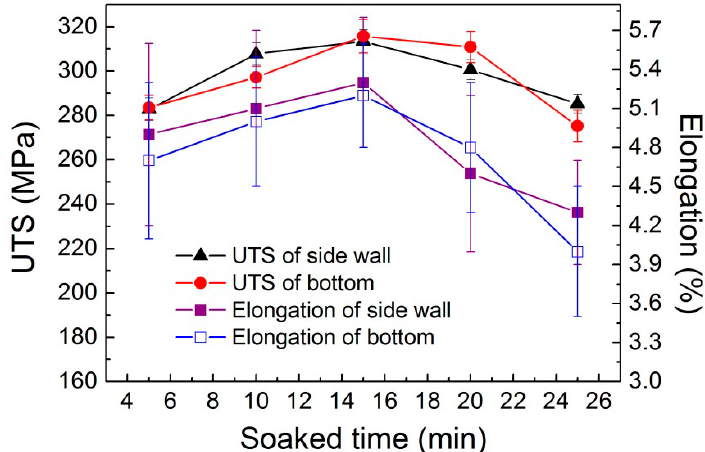
Figure 10. Mechanical properties of the thixoformed part soaked for different times at 600 °C.